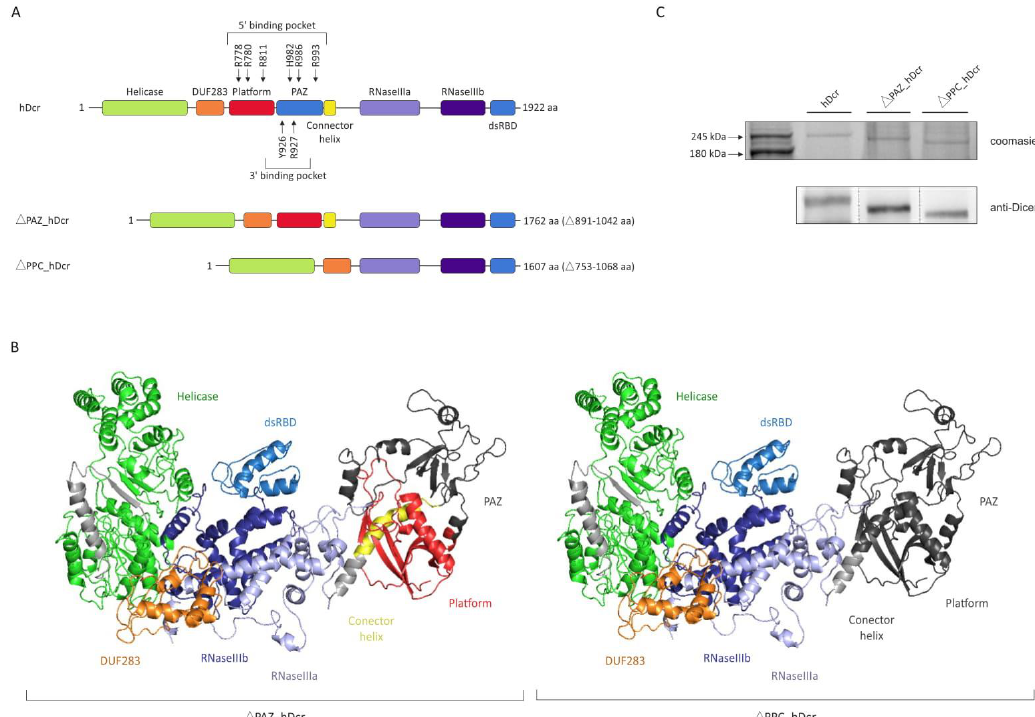
Figure 1. Full-length hDicer and the PAZ domain deletion variants . ( A ) Schematic representation of hDicer domain architecture and the PAZ domain deletion variants: ∆ PAZ_hDcr and ∆ PPC_hDcr. ( B ) The 3D structure of hDicer (PDB entry 5ZAL) visualized by PyMOL. The removed domains in ∆ PAZ_hDcr ( left panel ) and ∆ PPC_hDcr ( right panel ) are indicated in dark grey. ( C ) PAGE analysis of hDcr, ∆ PAZ_hDcr and ∆ PPC_hDcr preparations. The C-terminally 3xFlag-tagged proteins were expressed in 293T NoDice cells, then they were purified by immunoprecipitation and analyzed by SDS-PAGE followed by: Coomassie Blue Staining ( upper panel ) or Western blotting with anti-Dicer antibodies specific to the 1701-1912 aa hDicer region (bottom panel) .